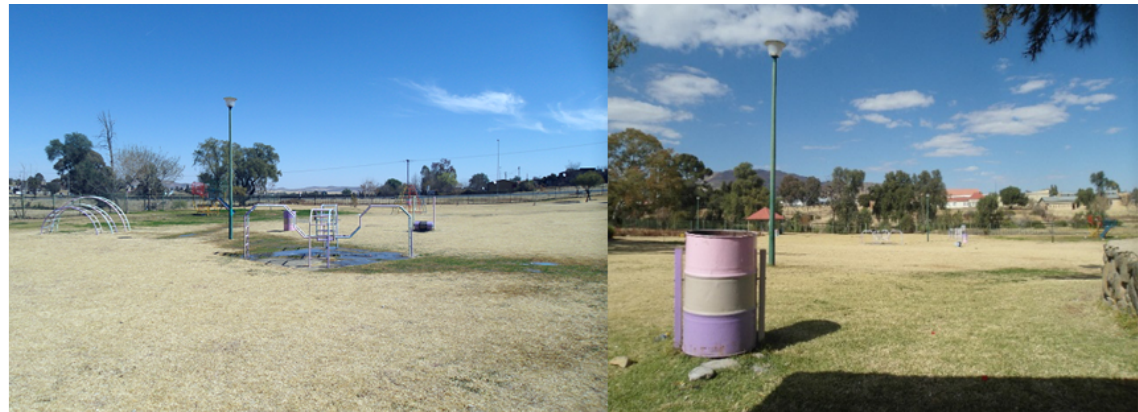
Figure 9. Marshy conditions beneath play infrastructure (left) and an underutilised waste-disposal bin and light post (right). Source: photographs by